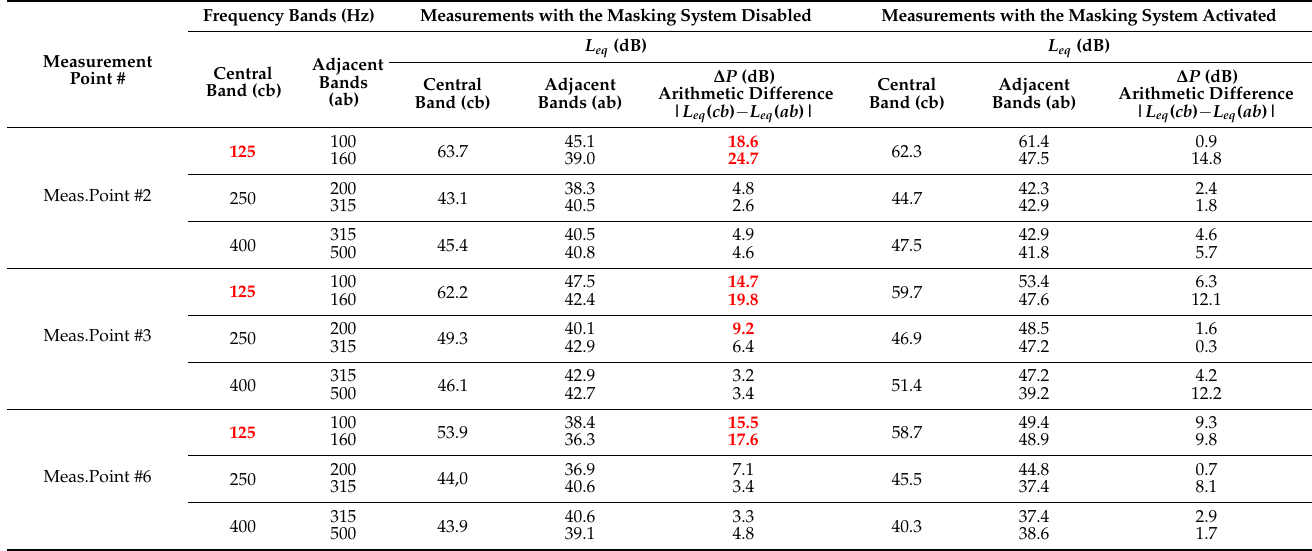
Table 2. Processing of measurements to identify the tonal component of noise. The red color indicates values that exceed the criteria defined in Table 1. Measurements with the Masking System Disabled Measurements with the Masking System